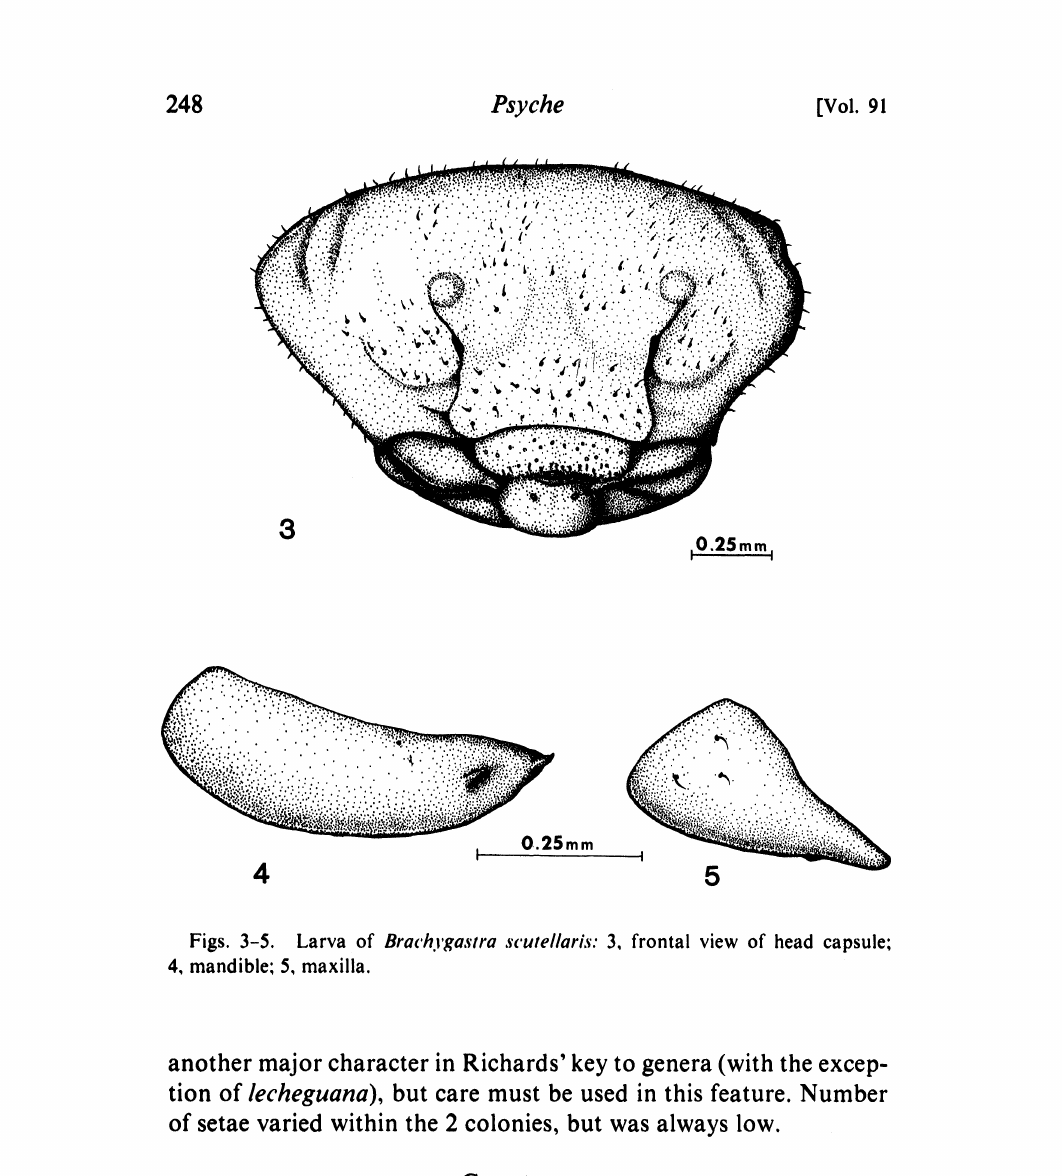
Figs. 3-5. Larva of Brachygastra scutellaris: 3, frontal view of head capsule; mandible; 5,